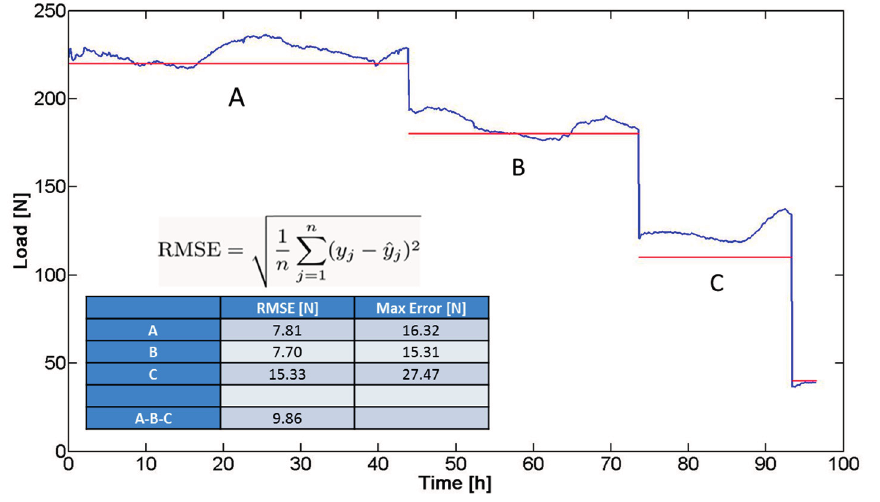
Figure 11. Force signal trend (Blue Line) and known compression force values applied with the mechanical testing system (Red Lines). The table shows the values of average errors found in every step (A–C) of the test. The errors are expressed as absolute values (N) and as a percentage of the ideal value. An average error of 8.85 N is